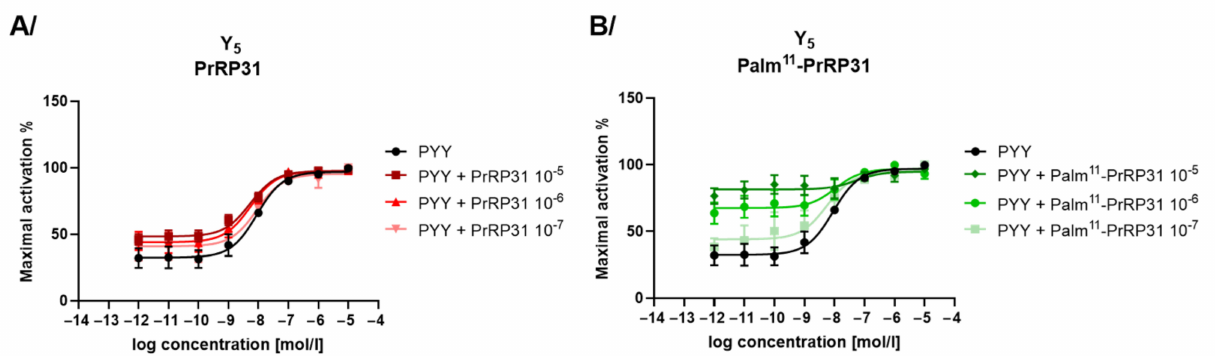
Figure 6. Antagonist mode assay showing effect of ( A ) PrRP31 and ( B ) palm 11 -PrRP31 at Y 5 receptor together with PYY agonist. Data are presented as mean ± SEM, and the experiments were performed in duplicates and repeated at least two times and analyzed using nonlinear